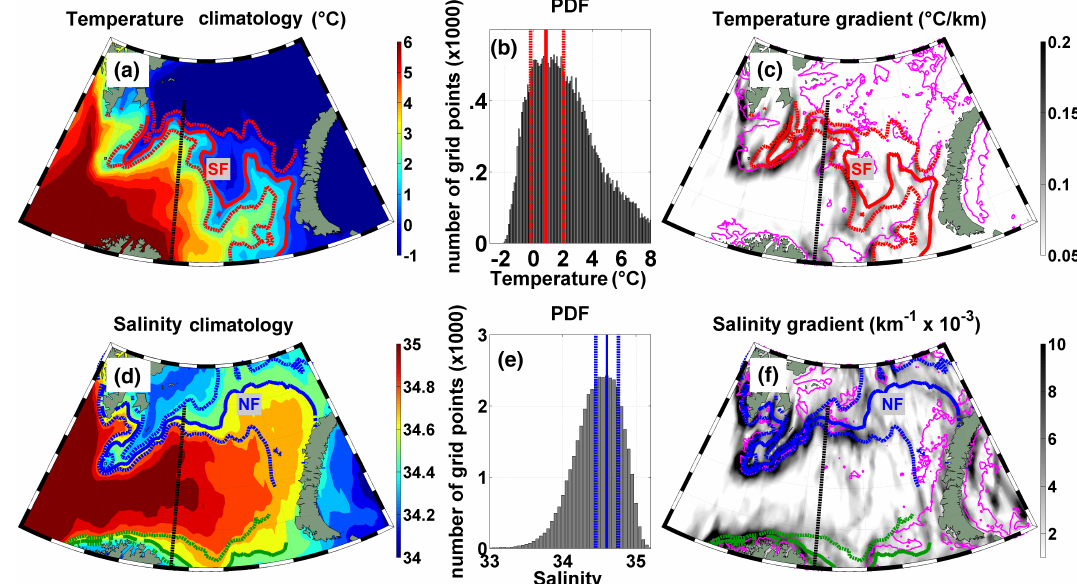
Figure 6. Temperature ( ◦ C) (a) and salinity (d) climatology for the 1980–2011 period (50–100m layer, August–September). Probability density functions (PDFs) of the temperature and salinity fields are respectively shown in (b) and (e) . Horizontal gradients of temperature (c) and salinity (f) . The Southern Front (SF) (between the dashed red lines, + 2 and − 0.3 ◦ C isotherms) and the Northern Front (NF) (between the dashed blue lines, 34.45 and 34.75 isohaline) are shown. Vardø section: black dashed